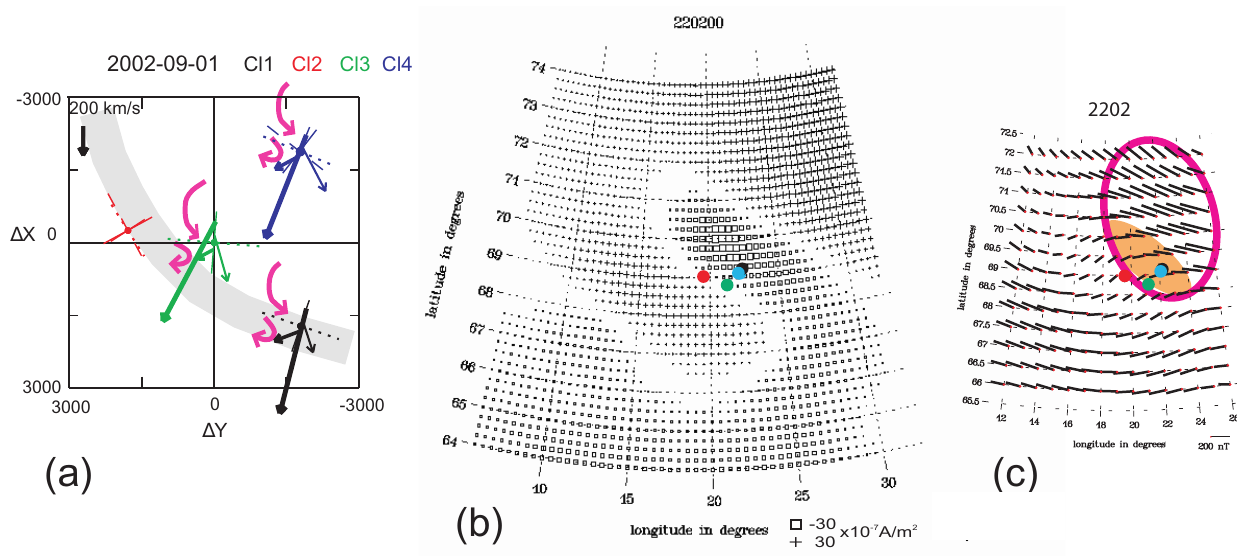
Fig. 11. ( a ) Possible shape of the dipolarization front illustrated on top of the relative location of the four Cluster spacecrafts in GSM X − Y plane with flow vectors at three different sequences in the same manner as Fig. 5a. The pink arrows show the sense of the flow shear ahead and behind the dipolarization front. ( b ) The curl of the equivalent current at 22:02 UT and the footpoints of Cluster. Crosses correspond to the downward (positive) direction and squares to the upward (negative) direction. ( c ) Equivalent current pattern at 22:02 UT, together with the footpoint of Cluster. The most likely location of the conjugate region of the flow channel (pink) and the most likely center of auroral precipitation region (orange) are illustrated (see text for